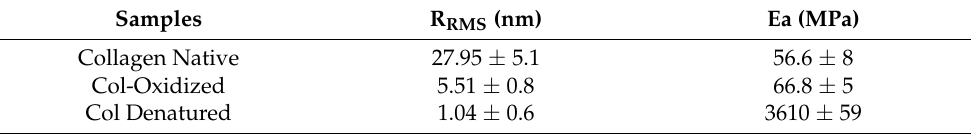
Table 5. Roughness values and Young’s modulus for native, oxidized, and denatured collagen. Samples R RMS (nm) Ea (MPa) Collagen